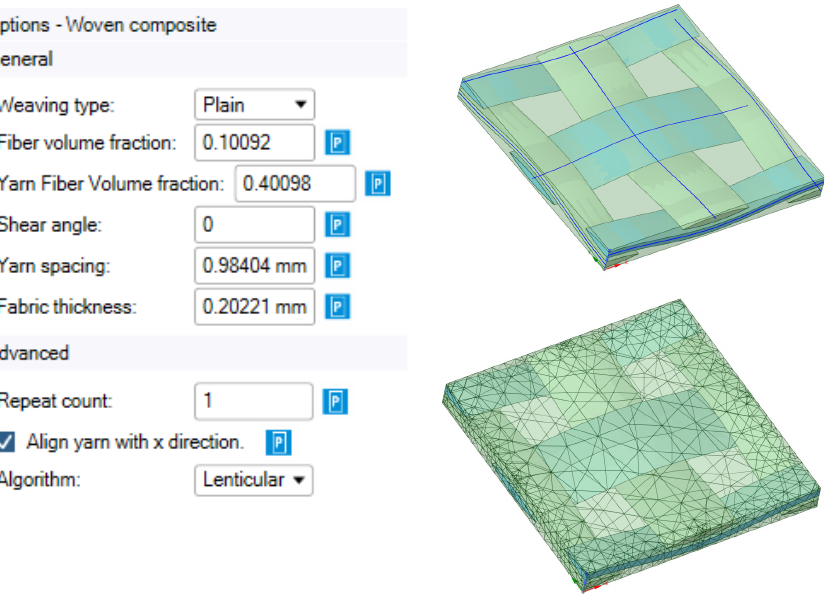
Figure 3. Initial data for constructing geometry, geometric and finite element RVE models.